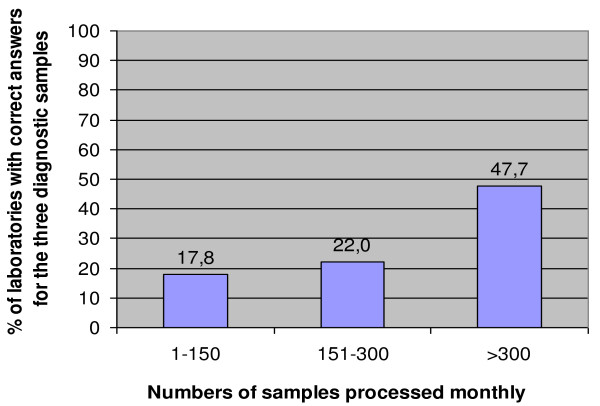
Numbers of samples processed monthly by the participants associated with the percentage of correct answers for the three diagnostic samples.